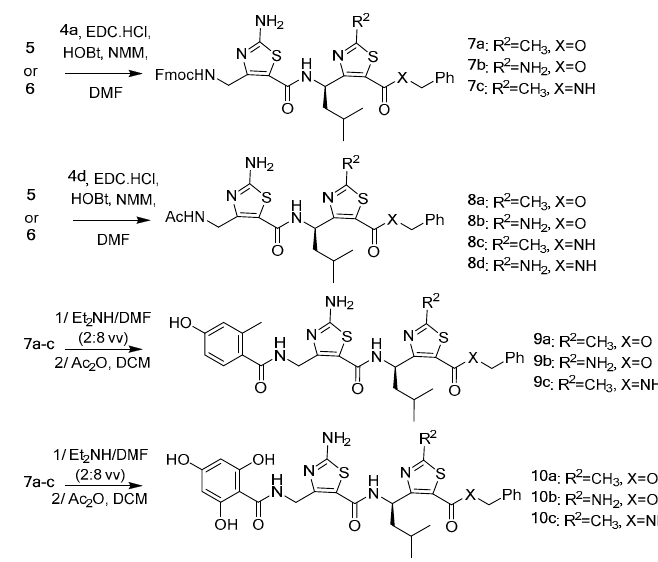
Scheme 2. Synthesis of the ATC-based γ -dipeptides.